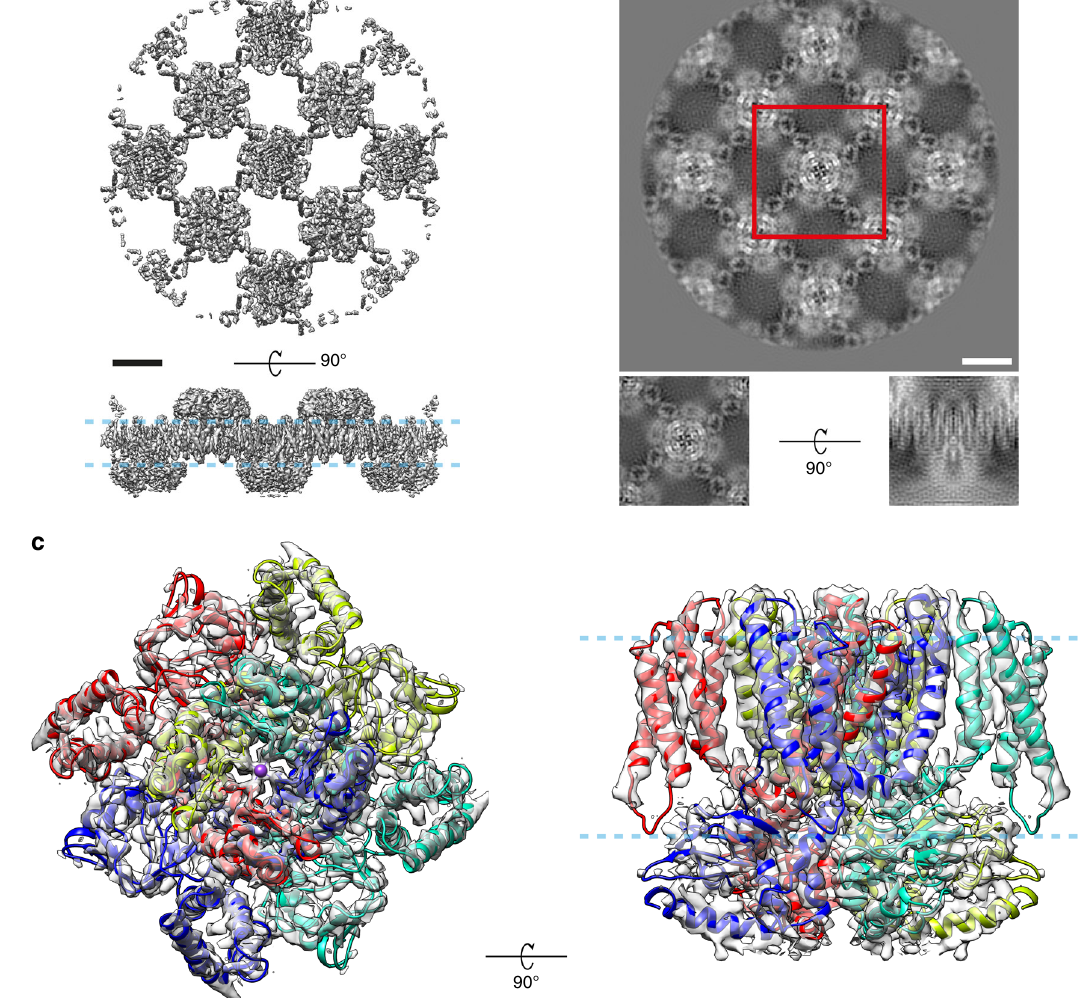
Fig. 2 The cryo-EM map of full-length MloK1 at 4 Å. The map was obtained from the consensus single-particle re fi nement of 2D crystal data in FREALIGN. a The full re fi ned map containing approximately nine MloK1 tetramers; total molecular weight over 1 MDa. b Projection of the full map along the z axis. The sub-volume used for postprocessing is indicated (red box). Insets: projections of the central sub-volume orthogonal to the xy and xz planes. c The postprocessed map of the central tetramer with the re fi ned atomic model fi t into the density, viewed from the extracellular side and parallel to the membrane plane. The pale blue dashed lines indicate the approximate position of the lipid bilayer. Scale bars: 50